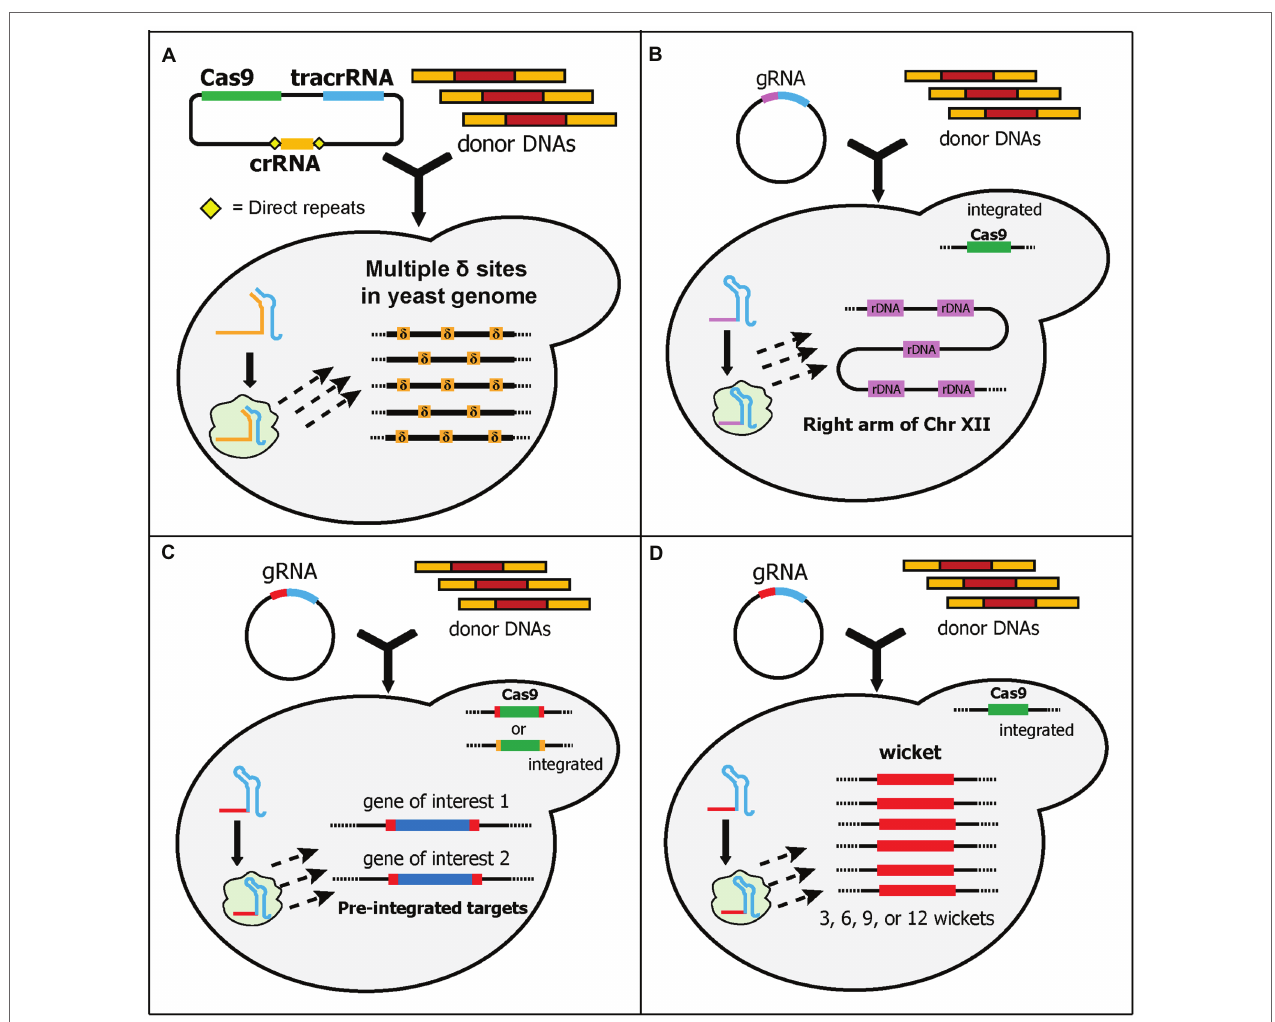
FIGURE 4 | Schematic diagram of multiplex gene-editing pre-defined sequences in the genome using a single gRNA (part 1). (A) Shi et al. used δ sites of Ty elements in the yeast genome as the target. More than 30 δ sites ( δ , orange boxes) are scattered across all chromosomes in the yeast genome. Therefore, multiple copies of donor DNA can be integrated. Note that they used a separate crRNA and tracrRNA plasmid. (B) Wang et al. targeted ribosomal DNA (rDNA, purple boxes) for integration sites. rDNA is located at the right arm of chromosome XII. Around 100–200 copies of rDNA can be found in the yeast genome. Cas9 was integrated into the genome. (C) Finnigan and Thorner generated synthetic target sequences (red or orange boxes) that flanked the genes-of-interest (GOIs) and Cas9 , which was integrated into the yeast genome. The gRNA cleaves the sequences and causes DSBs at the 5 ' and 3 ' ends of GOIs and/or Cas9 , removing them from the genome. Concurrently, the donor DNAs can be integrated at those sites. Note that although different gRNA sequences can be used, only one gRNA sequence (red box) is shown. (D) Hou et al. generated “wicket” sequences (red boxes) which contains a 23-bp synthetic target flanked by 5 ' and 3 ' 50-bp synthetic homology arms. Wickets and Cas9 were integrated into the yeast genome. Yeast strains with 3, 6, 9, or 12 wickets were created. Therefore, multi-copies of donor DNA can be integrated in one